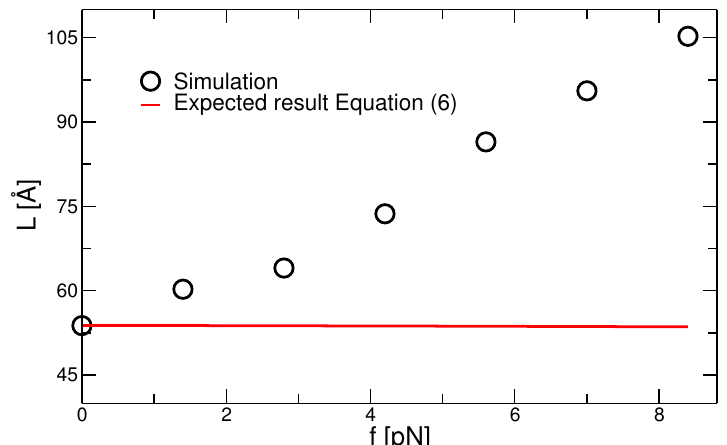
Figure 9. Simulation results for the stem length formed during isothermal crystallization performed by quenching the melt to T q = 430 K, black symbols. The theoretical prediction as discussed in the text is given by the red line according to Equation (7). The symbols indicate the values of the force used in the